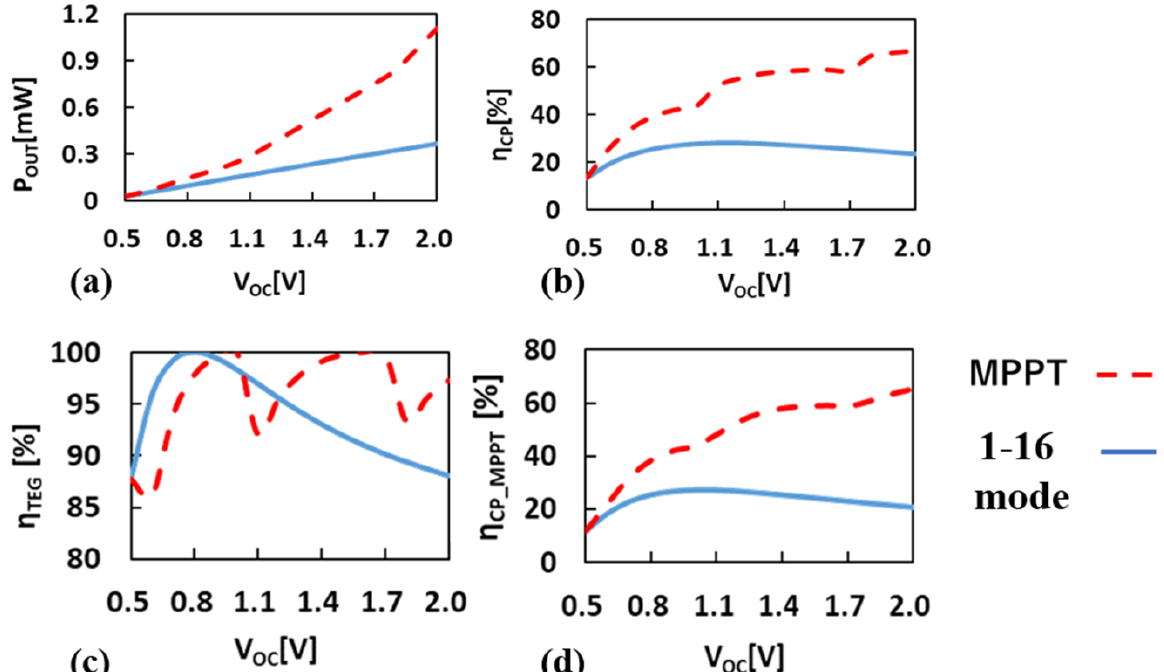
Figure 11. P OUT ( a ), η CP ( b ), η TEG ( c ), and η CP_MPPT ( d ) as a function of V OC in MPPT and a fixed 1-16 modes.